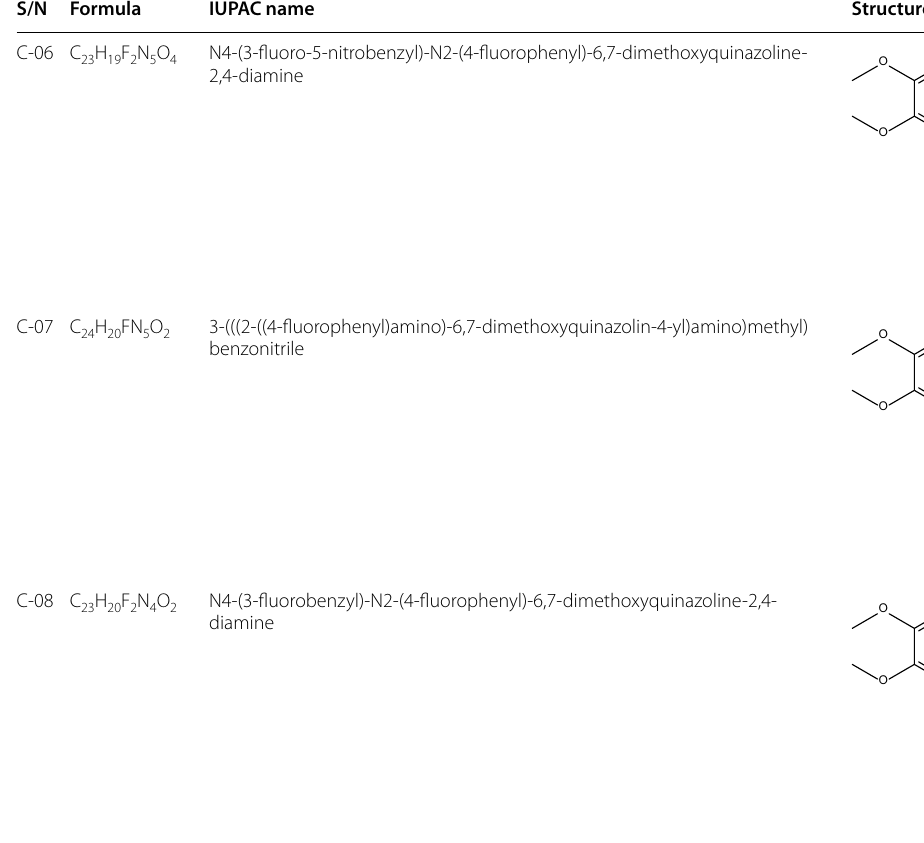
Table 1 (continued) S/N